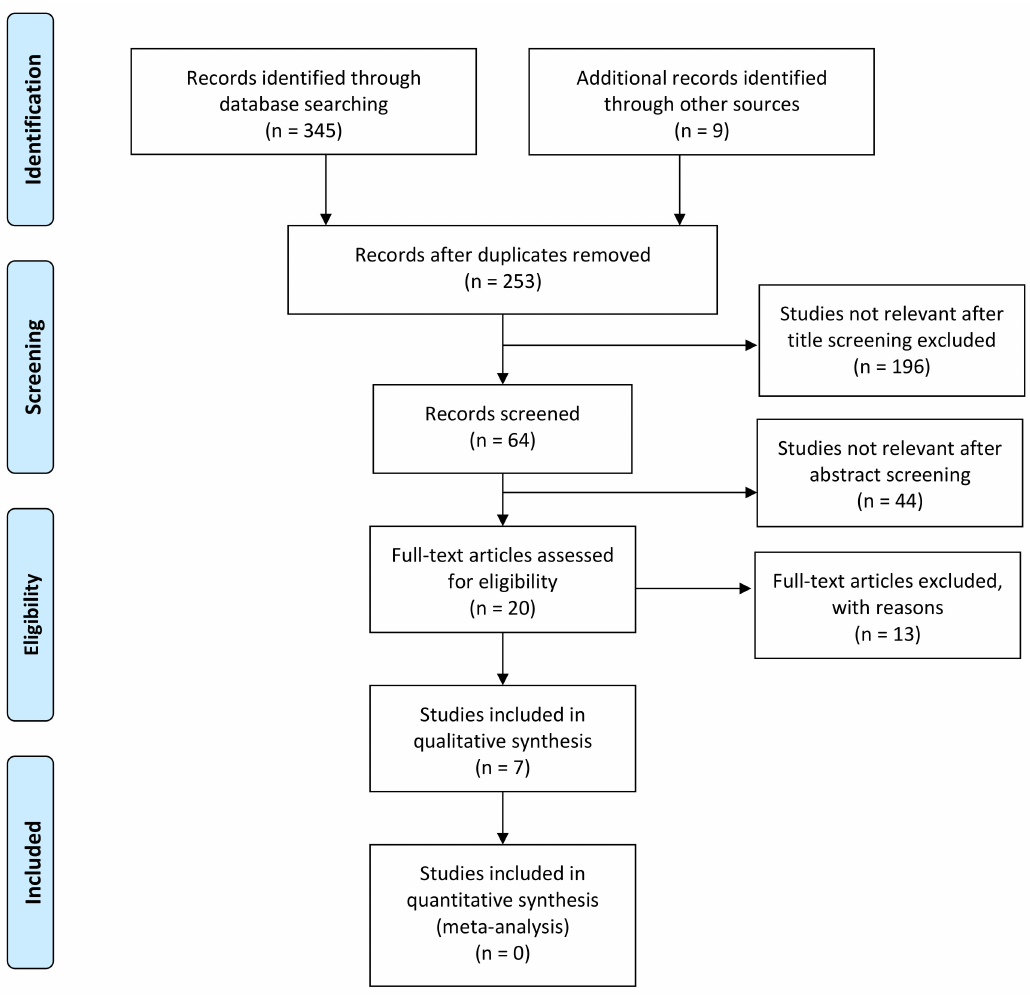
Figure 2. PRISMA flow